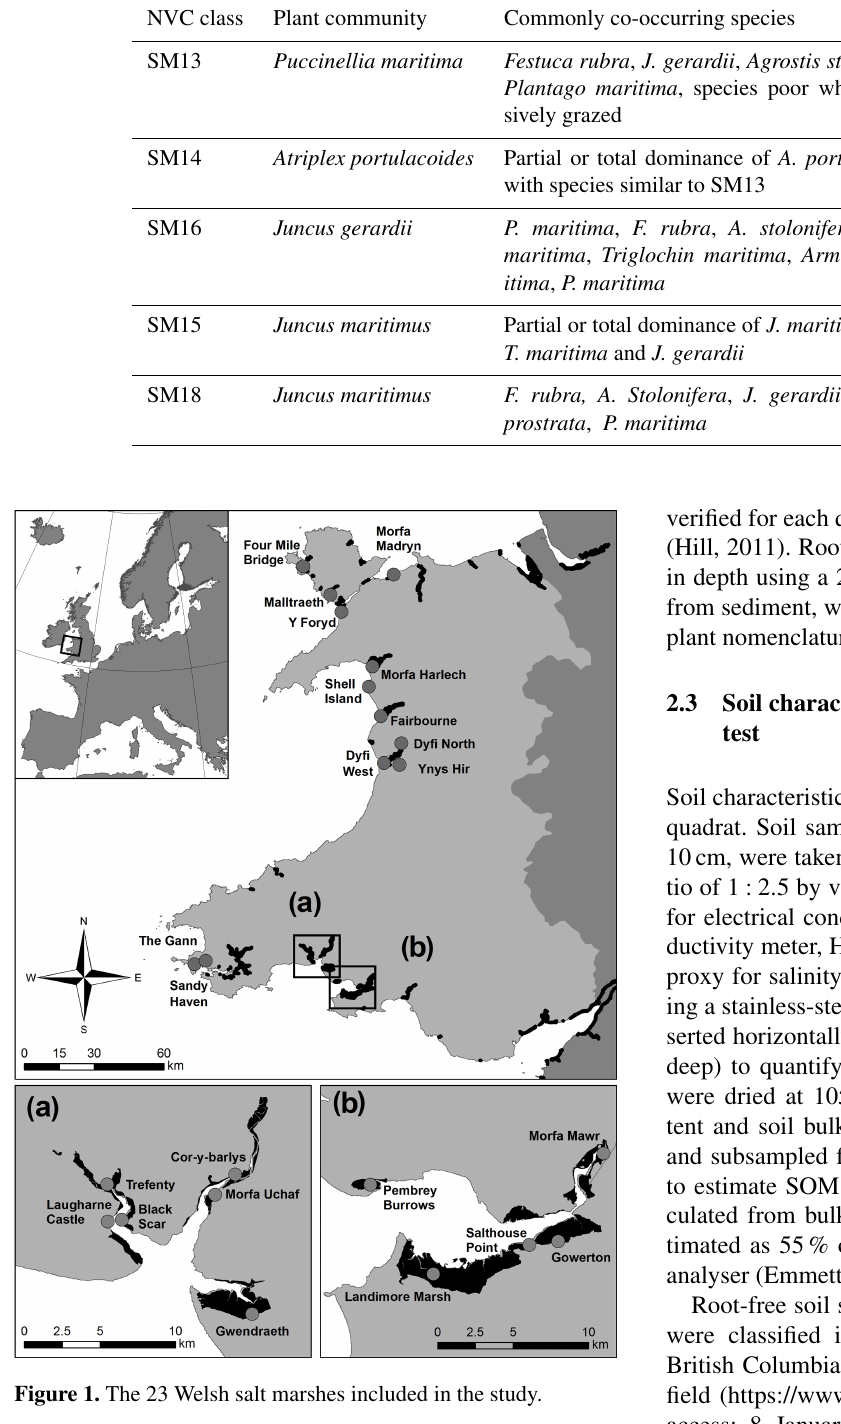
Table 1. Salt-marsh vegetation types, associated National Vegetation Classification (NVC) class, and marsh intertidal position (zone) (http: //jncc.defra.gov.uk/pdf/Salt-marsh_Comms.pdf, last access: 8 January 2019).